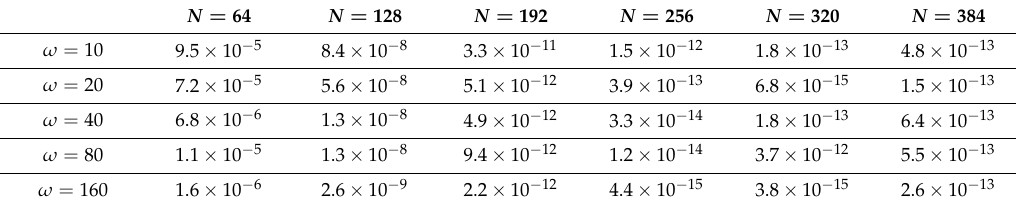
Table 11. Absolute errors of C2DSC-Levin for Example